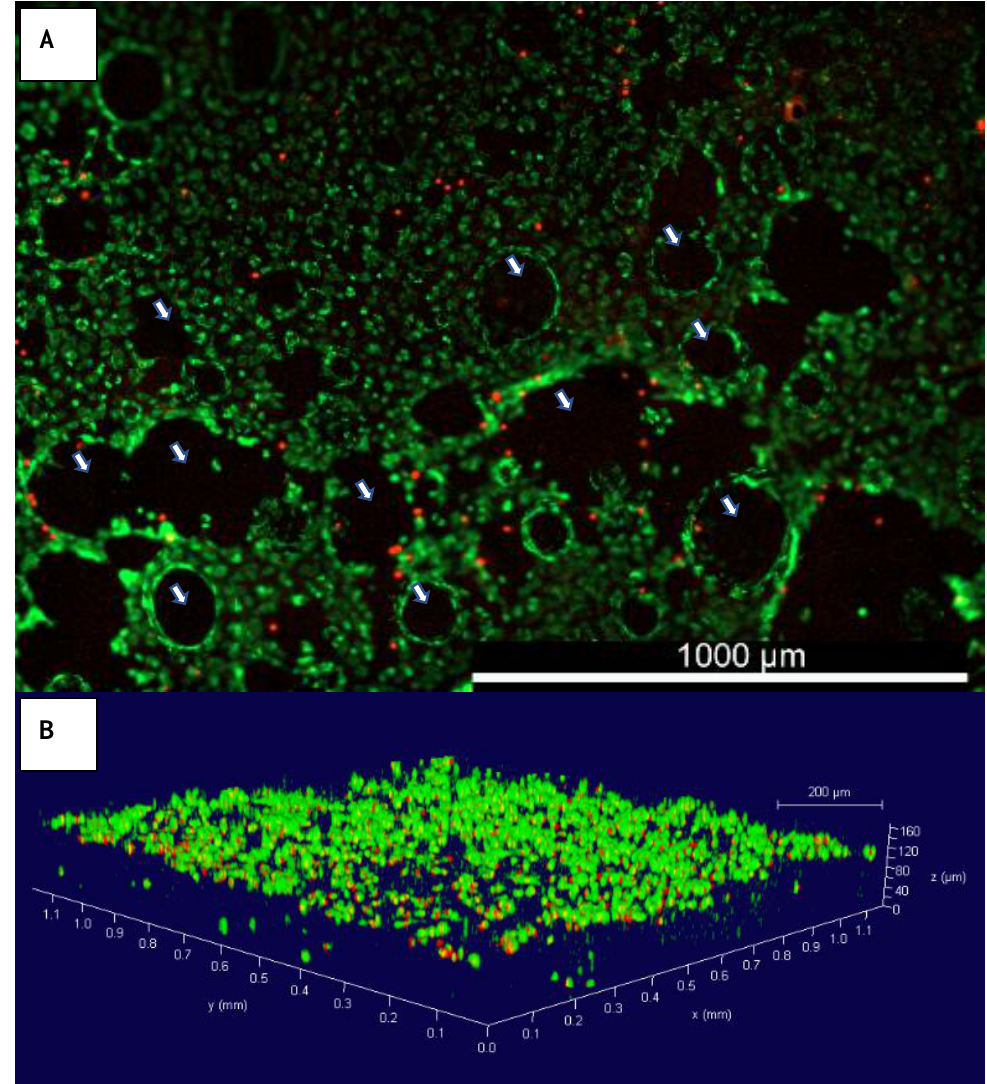
Figure 2 . ( A ) Representative image of the distribution of bovine articular chondrocytes grown in SA – GEL – GA at day 45 imaged 1 h after incubation with membrane-specific DiOC6(3) dye and propidium iodide, magnification 4 × ; ( B ) 3D rendering of bovine chondrocytes grown in SA–GEL–GA using confocal microscopy; green is the cellular membrane, and red is the nucleus, magnification 10×; macropores.